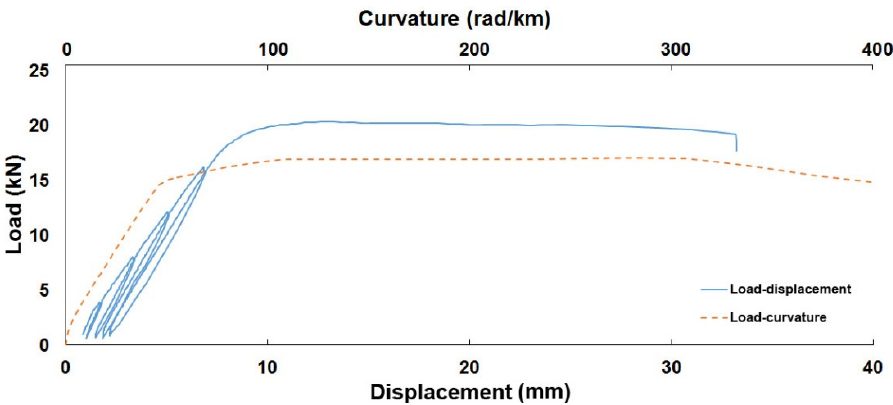
Figure 7 . Cycle loading applied to beam with notch.